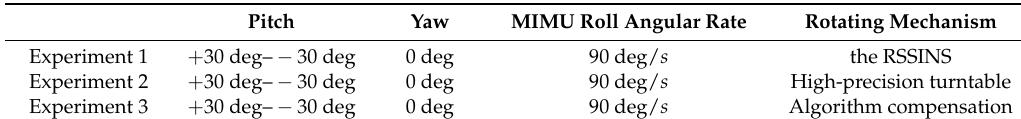
Table 4. Setting of the experiment conditions.